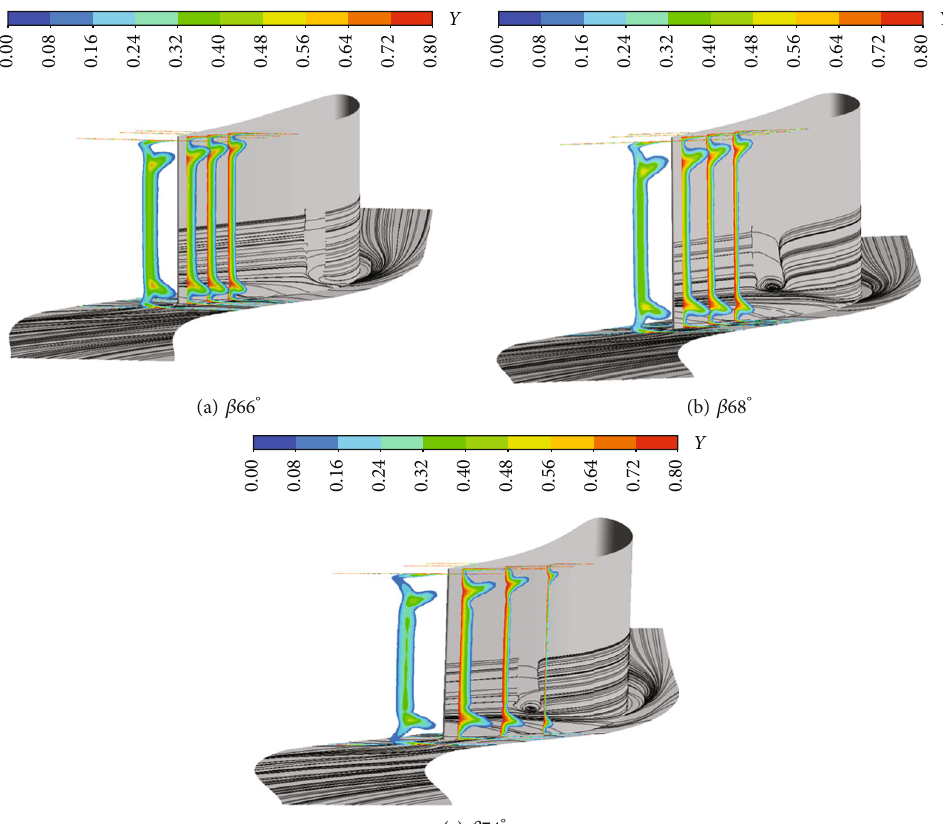
Figure 17: Comparison of total pressure loss and endwall streamline for di ff erent exit